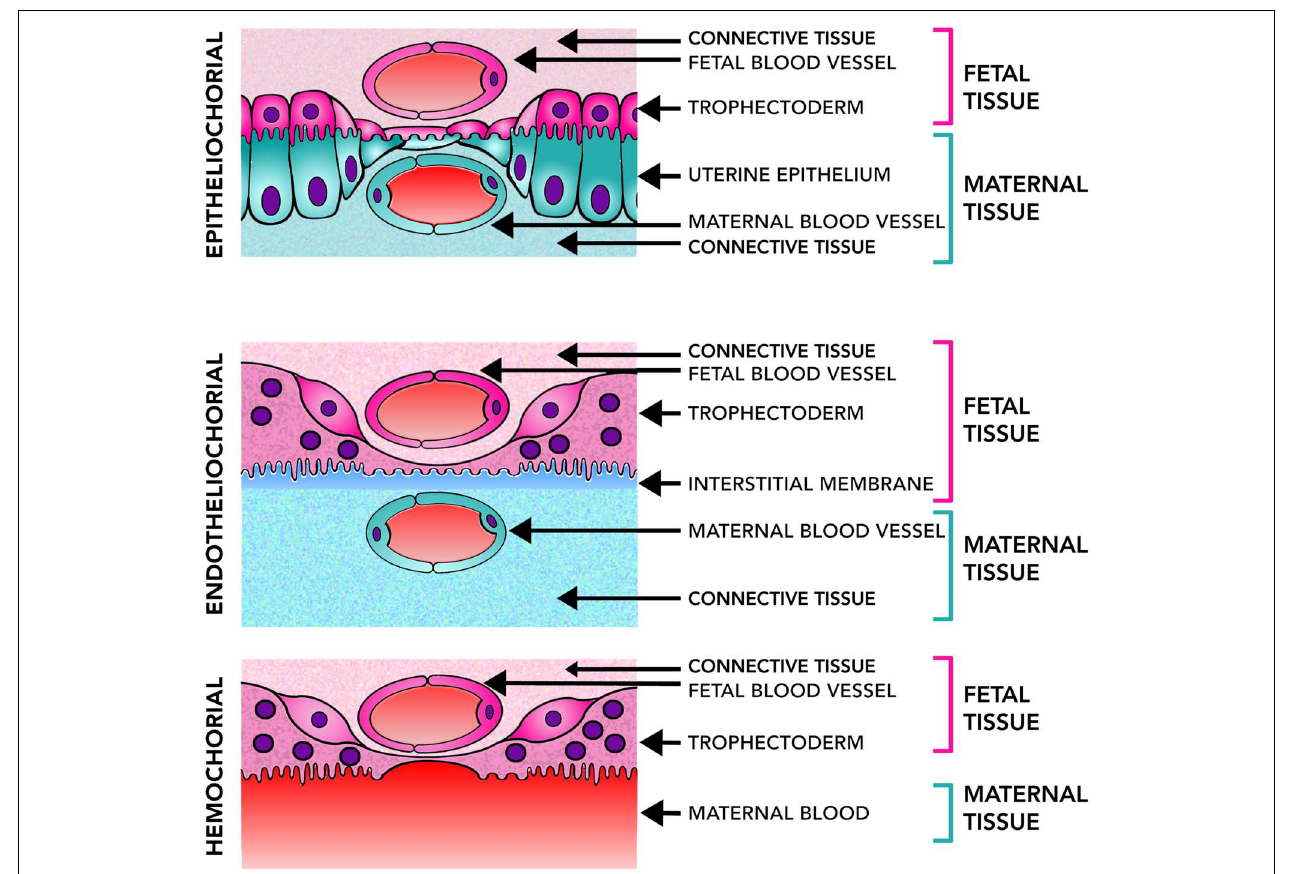
FIGURE 2 | Placental level of invasiveness. The placenta varies across mammalian species in the invasiveness and their access to maternal blood flow. Epitheliochorial placentas, the least invasive, have three layers of maternal tissue separating the fetus from maternal blood. Endotheliochorial placentas are partially invasive and only the endothelial wall of the maternal blood vessels, and some interstitial tissue, separates the fetus from the